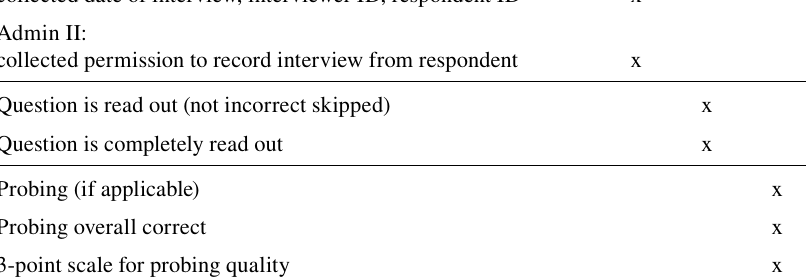
Figure 1 Coding scheme for audio recordings of the background questionnaire of PIAAC in